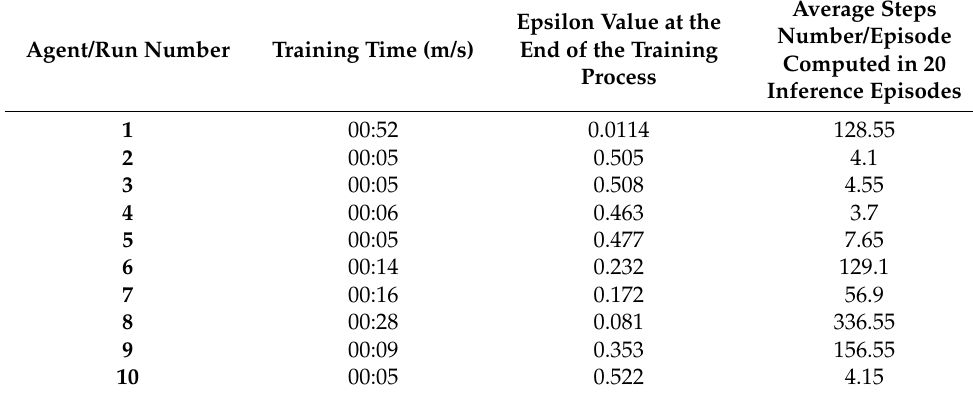
Table 11. Details of the training process of the 10 analyzed agents.